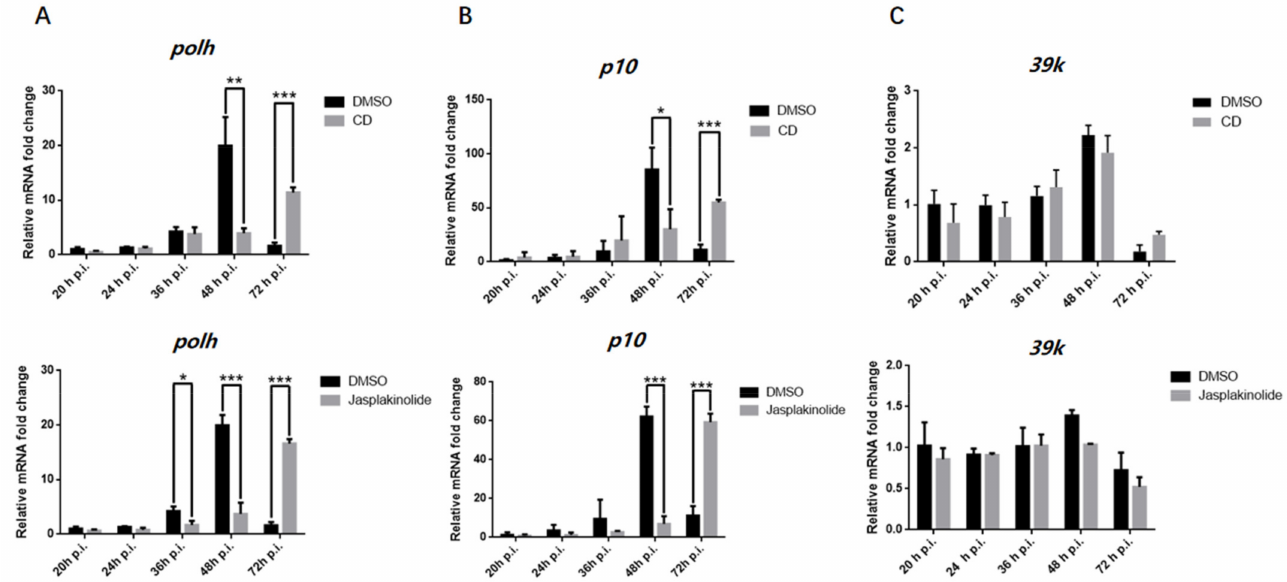
Figure 2. RT-qPCR analysis of the effect on polh and p10 transcription caused by CD and Jas. ( A ) Quantitative real-time PCR analysis of polh in BmN cells treated with CD, Jas, or DMSO (Ctrl) ( n = 3; *, p < 0.05; **, p < 0.01; ***, p < 0.001). ( B ) Quantitative real-time PCR analysis of p10 in BmN cells treated with CD, Jas, or DMSO (Ctrl) ( n = 3; *, p < 0.05; ***, p < 0.001). ( C ) Quantitative real-time PCR analysis of 39k in BmN cells treated with CD, Jas, or DMSO (Ctrl) ( n = 3). The white columns are for the dimethyl sulfoxide (DMSO) treatment as control, the black columns are for CD and Jas treatment. The data indicate the means plus standard errors from three independent